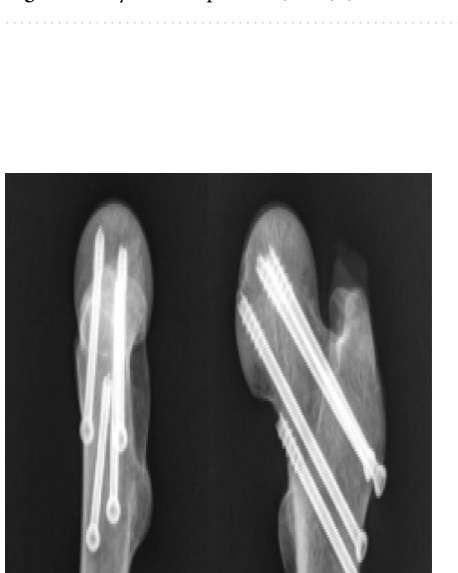
Figure 4. Dynamic hip screw (DHS) ( Note : Positive and lateral X-ray film after internal fixation).